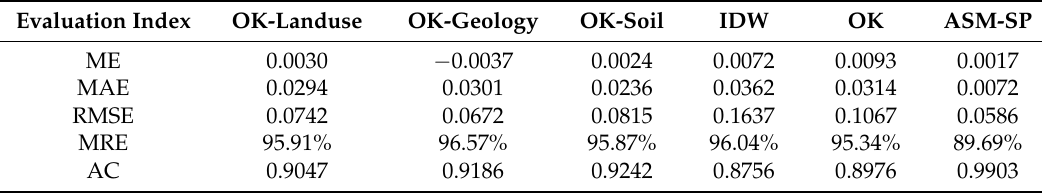
Table 4. Comparison of the accuracy of OK, OK-Landuse, OK-Geology, OK-Soil, inverse distance weighting (IDW), and ASM-SP